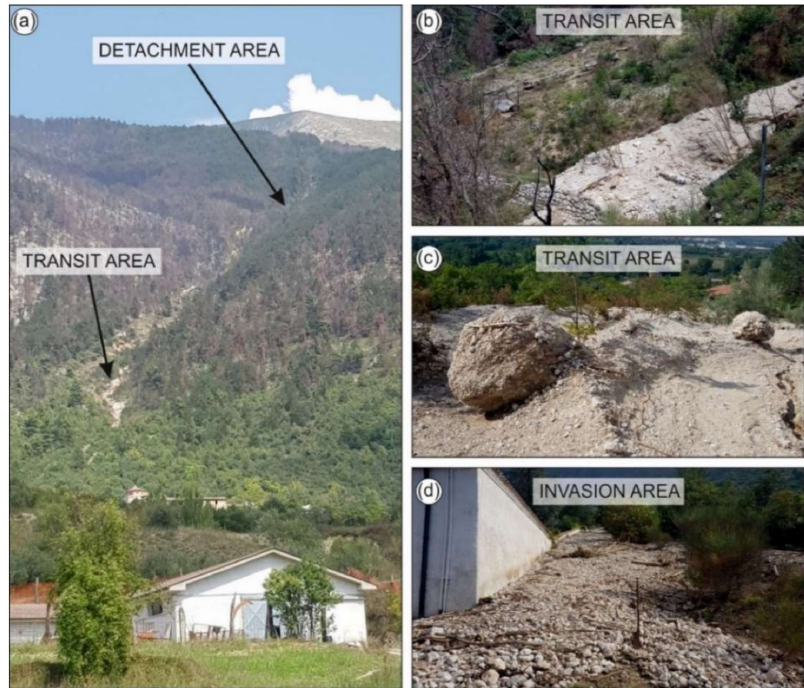
Figure 17. ( a ) Panoramic view of the debris flow channel; ( b – c ) detail of transit area with the presence of calcareous boulders and cobbles; ( d ) detail of invasion